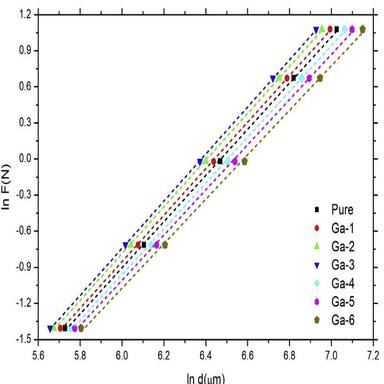
Differentiation of ln F with regard to ln d plots for the pure and Ga substituted Bi-site Bi-2212 materials.